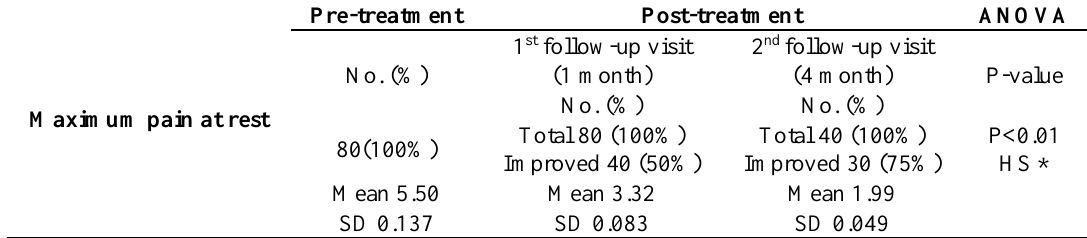
Table 3: Maximum pain at rest (before and after treatment).